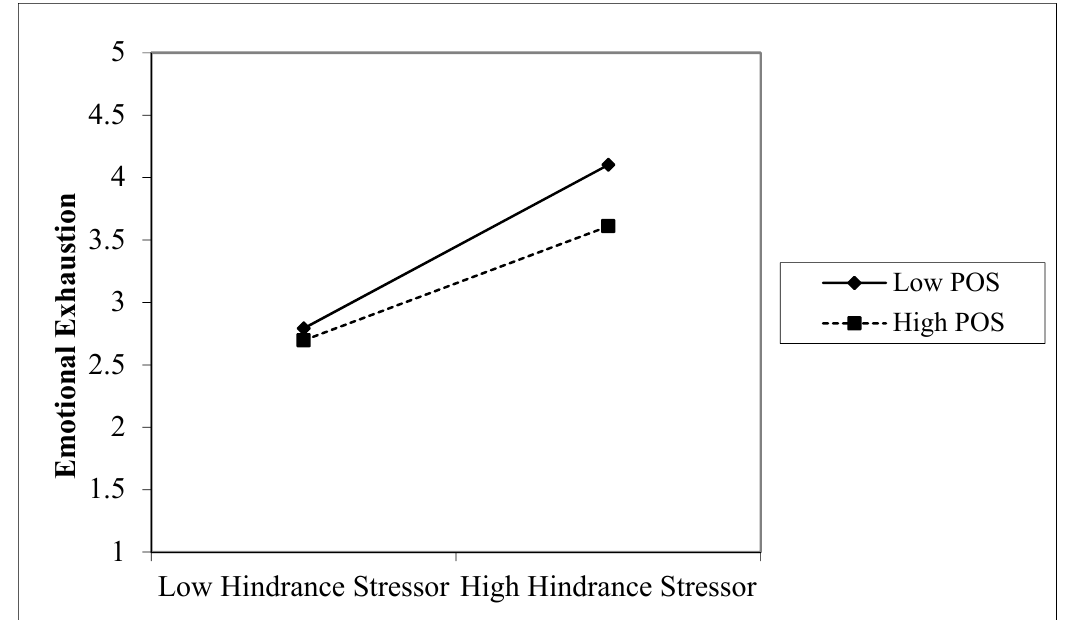
Figure 2. Interactive effects of hindrance stressors and POS on emotional exhaustion. POS = perceived organizational support.